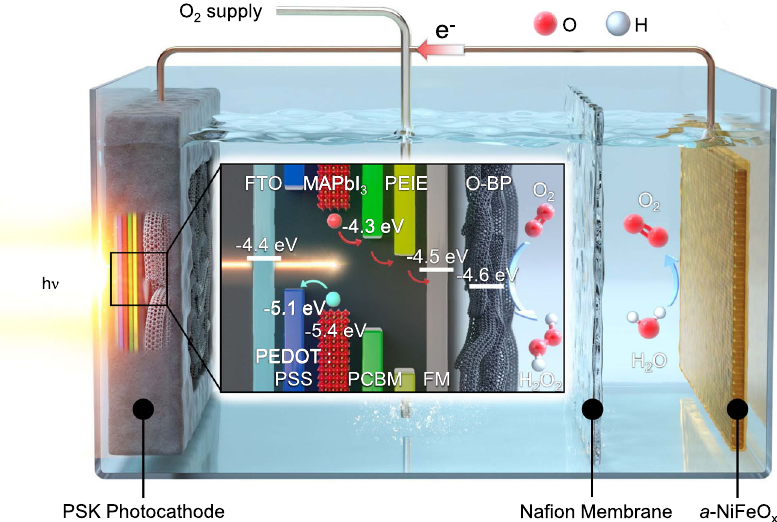
Fig. 1 Schematic illustration of the system demonstrating unassisted solar hydrogen peroxide (H 2 O 2 ) production. An inverse-structure methylammonium lead triiodide (MAPbI 3 ) perovskite (PSK) photocathode with oxidised buckypaper (O-BP) and an amorphous-based nickel – iron oxide ( a -NiFeO x ) with a carbon paper (CP) substrate are connected for bias-free H 2 O 2 production. Embedded copper wires connect the photocathode and anode to enable the photogenerated hole – electron pairs to fl ow in a closed circuit. Dissolved O 2 is reduced to H 2 O 2 by photocathode-mounted O-BP. The oxygen evolution reaction (OER) occurs at the a -NiFeO x /CP. De fi nitions: PCBM, [6,6]-phenyl C 61 butyric acid methyl ester; PEIE, polyethyleneimine; and FTO, fl uorine-doped tin oxide. The red-coloured arrow shows the direction of the movement of the electrons in the illustration while the simultaneously generated holes ’ direction is depicted by the blue-coloured